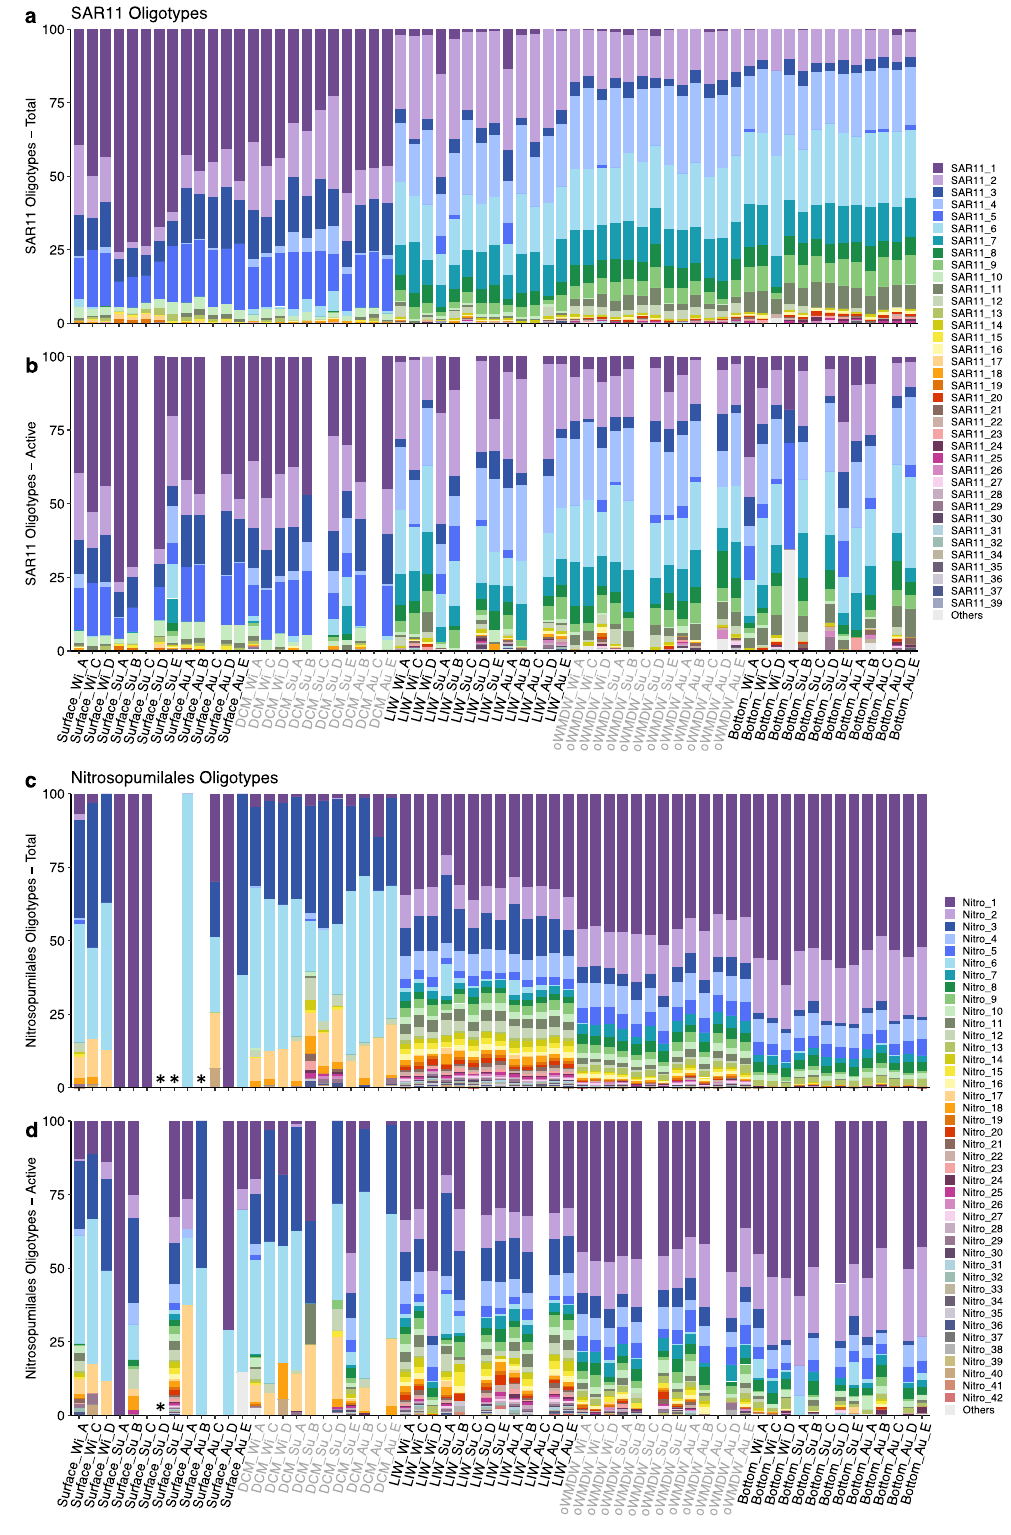
Figure 5. Oligotypes composition of ( a , b ) SAR11 and ( c , d ) Nitrosopumilales phylotypes for total and actively dividing samples. Stacked bar plots represent the relative abundance of oligotypes in the different samples, ordered by depth and labelled as Depth_Season_Station. Legends indicate phylotype_oligotype number. Oligotypes occurring in less than four samples are combined in ‘Others’ group. White gaps indicate samples not available or with no oligotype found (indicated by an asterisk). DCM: deep chlorophyll maximum; LIW: Levantine intermediate water; oWMDW: old western Mediterranean deep water; Wi: winter; Su: summer; Au: